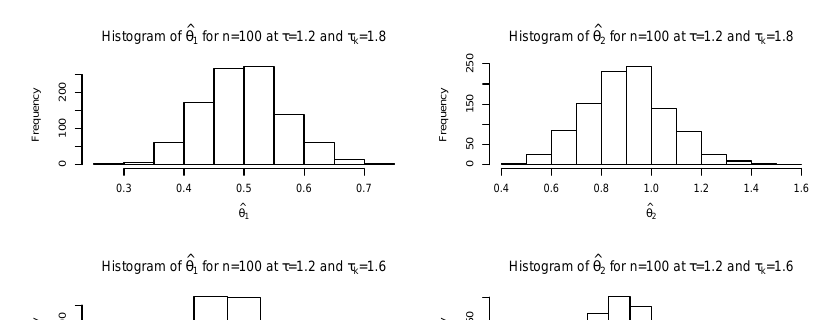
Figure 2 – Histograms of